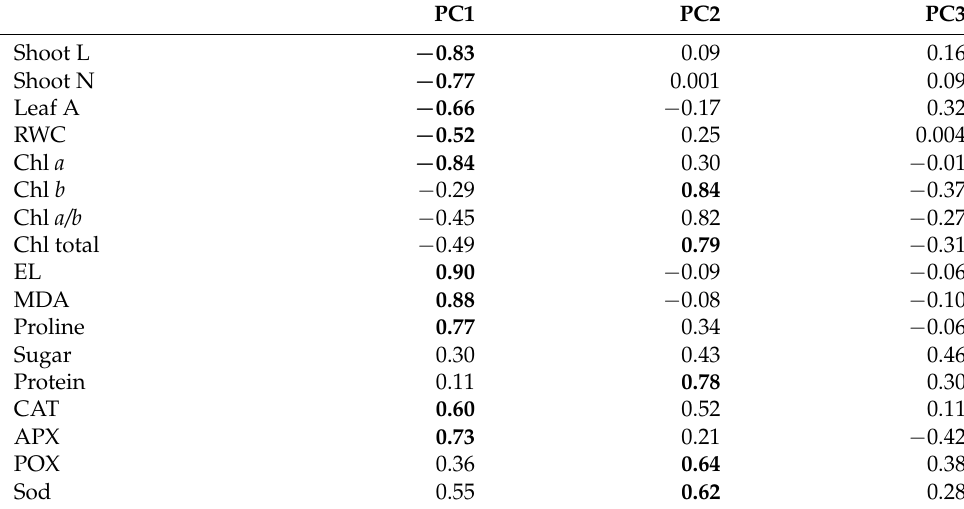
Table 2. Principal component factor loadings for 17 traits